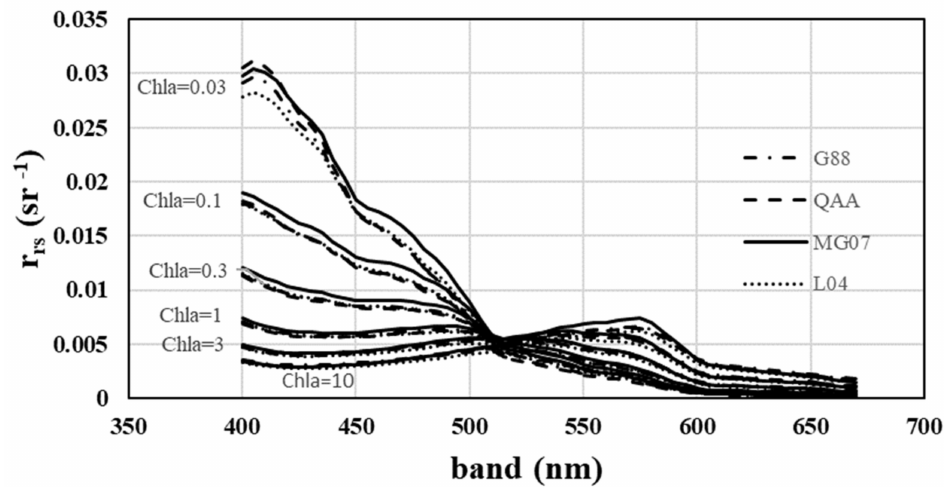
Figure 5. Differences in r rs λ of the G88, QAA, MG07, and L04 models, when the concentration of chlorophyll was 0.03, 0.1, 0.3, 1, 3 and 10 mg m − 3